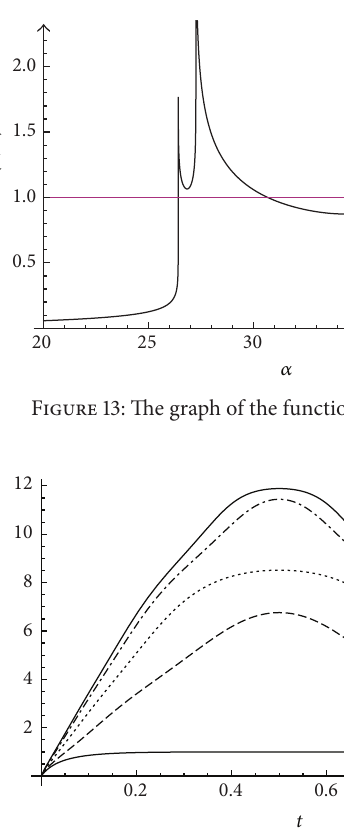
Figure 17: The graph of the function 𝑈(𝛼, 0.0343)